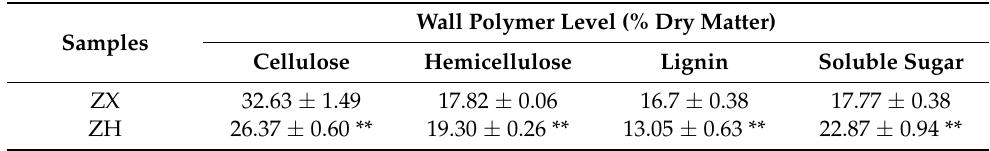
Table 1. Cell-wall compositions (% dry matter) of two corn (ZX, ZH) cultivars.